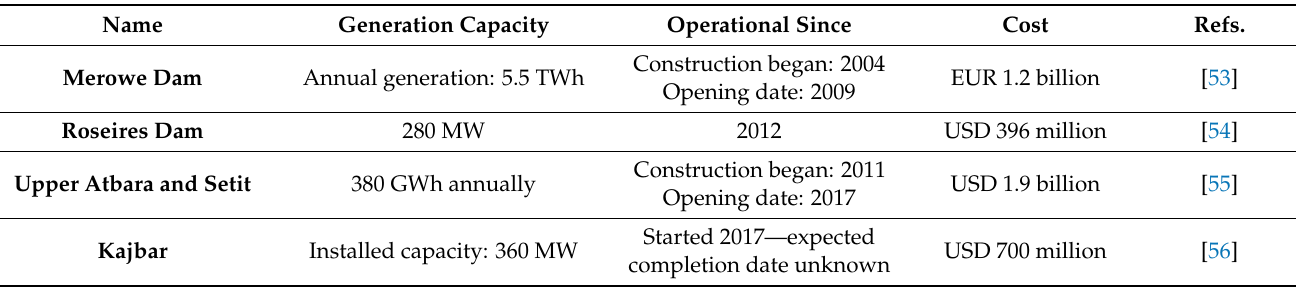
Table 8. Sudan hydropower